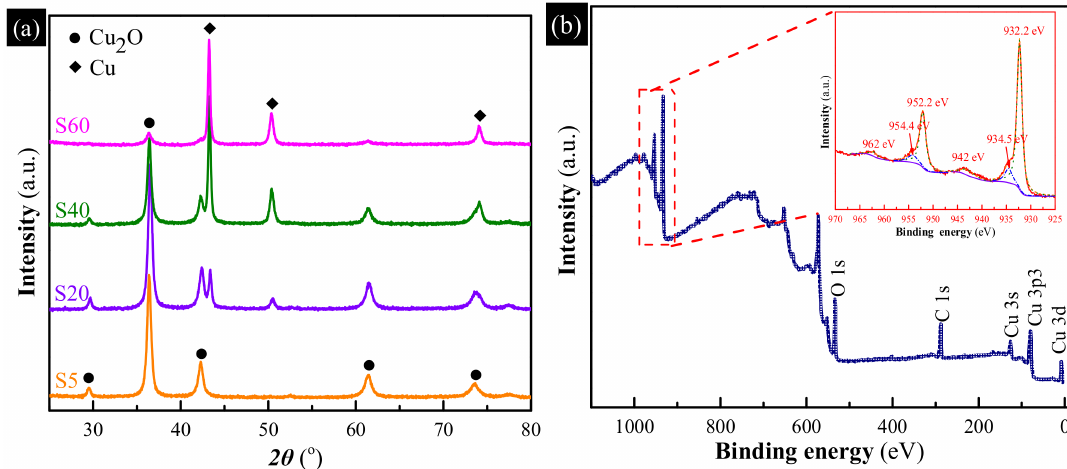
Figure 2. ( a ) X-ray diffraction (XRD) patterns of the as-synthesized samples obtained with different reaction time, inset are photos of the as-synthesized samples; ( b ) X-ray photoelectron spectroscopy (XPS) patterns of S40, inset is the high-resolution spectrum of the Cu 2p